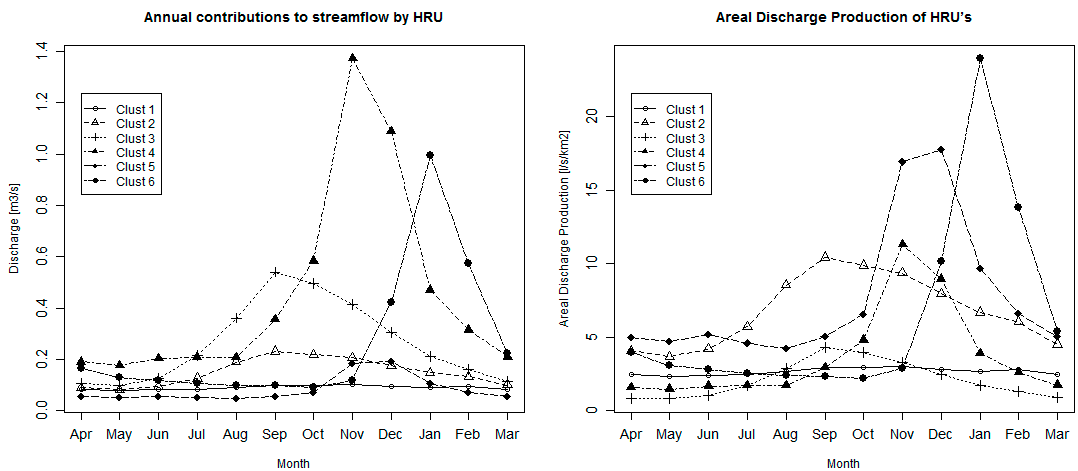
Figure 8. Mean monthly discharge of each HRU contributing to total streamflow at the outlet, for the six HRUs scenario. ( Left ) mean annual discharge, ( right ) mean annual discharge production by area.